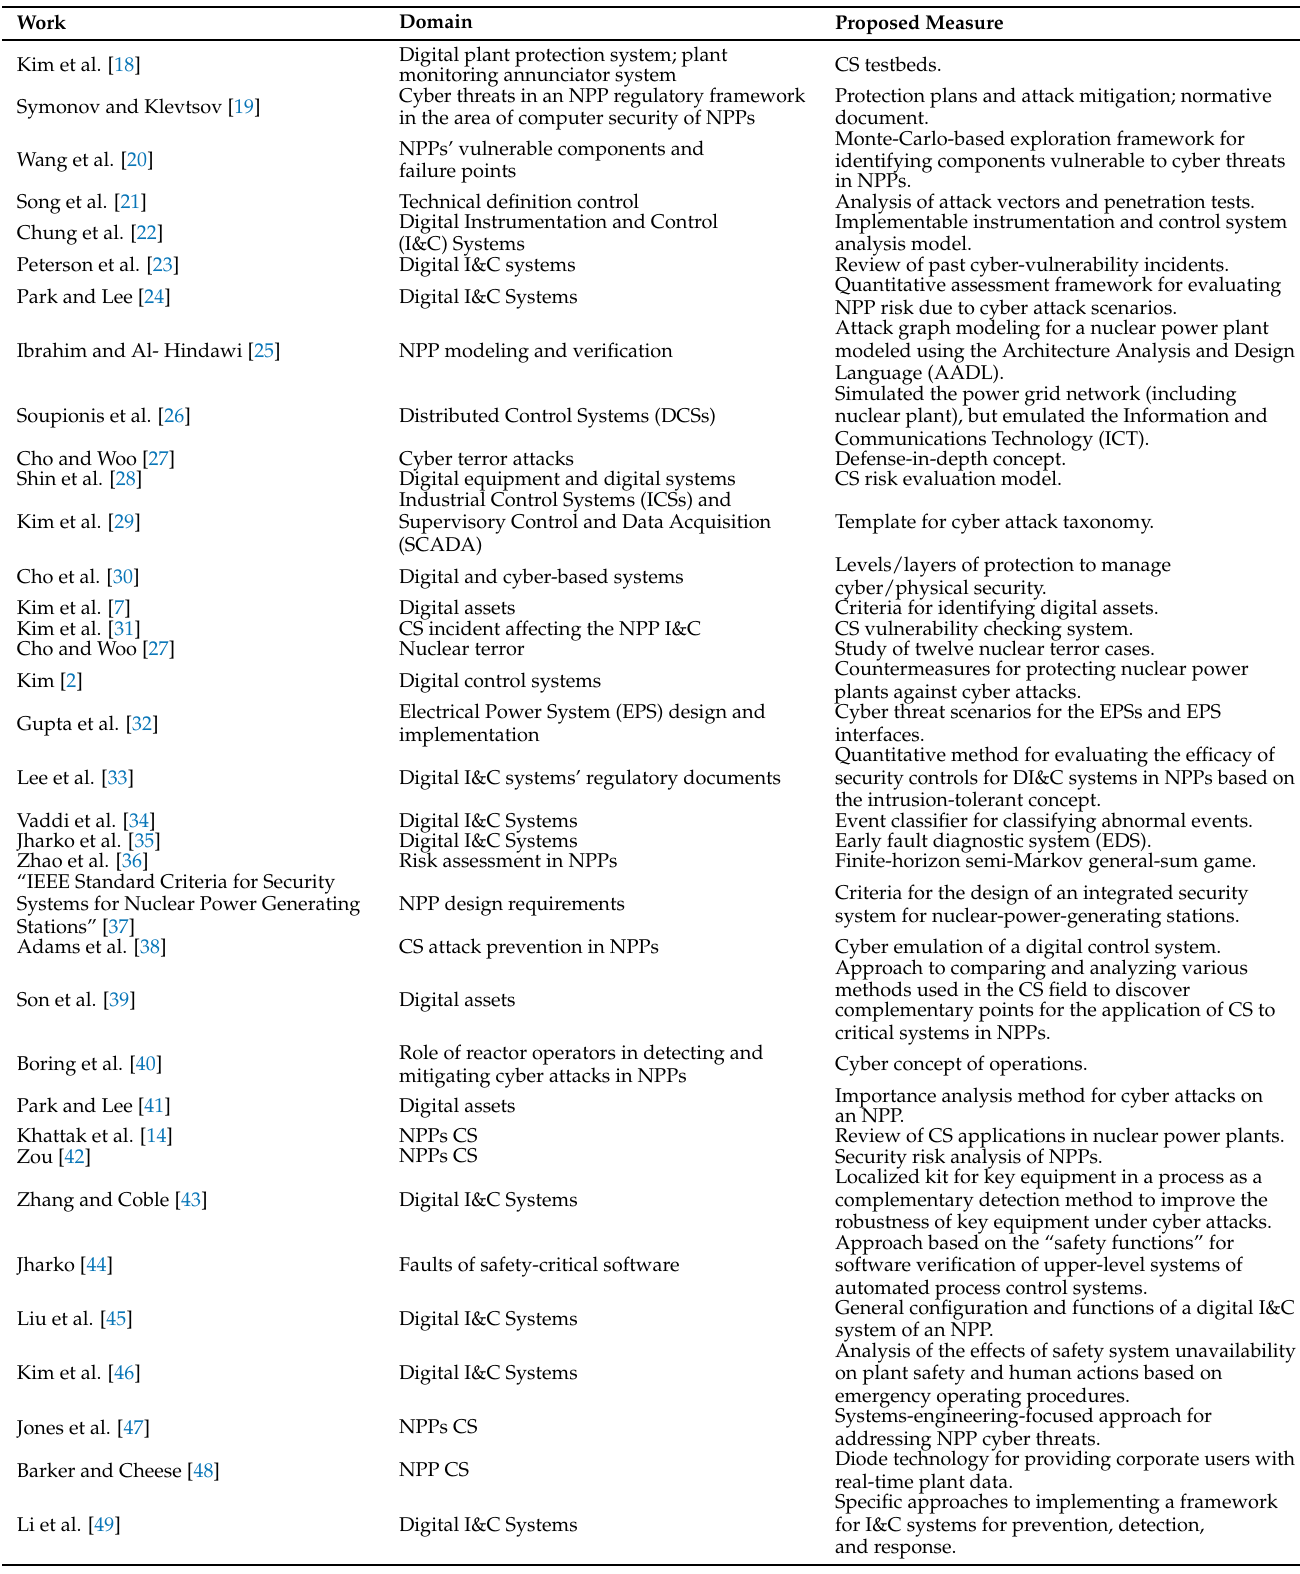
Table 4. Domain and proposed CS measures of the works included in the literature